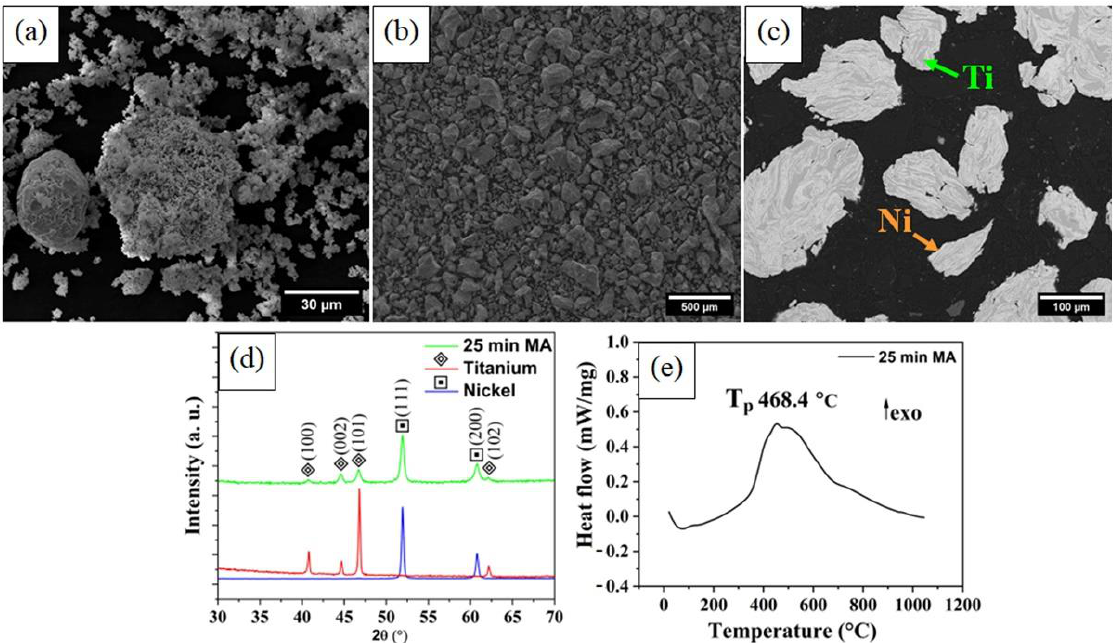
Figure 2. SEM morphology of the elementary powders: ( a ) nickel and ( b ) titanium. ( c ) Micrography of the MA-processed powders. ( d ) XRD patterns of the starting powders and the MA-processed powders. ( e ) DTA heating curve of MA-processed powders.